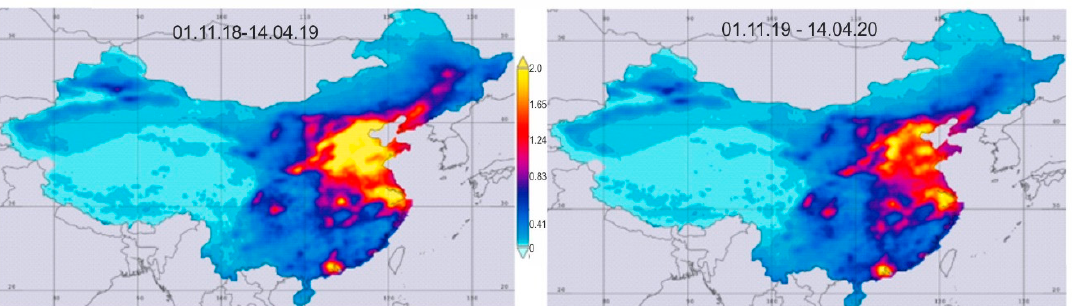
Figure 2. OMI-based seasonal mean tropospheric NO 2 (10 15 molec/cm − 2 ), from November 2018 to April